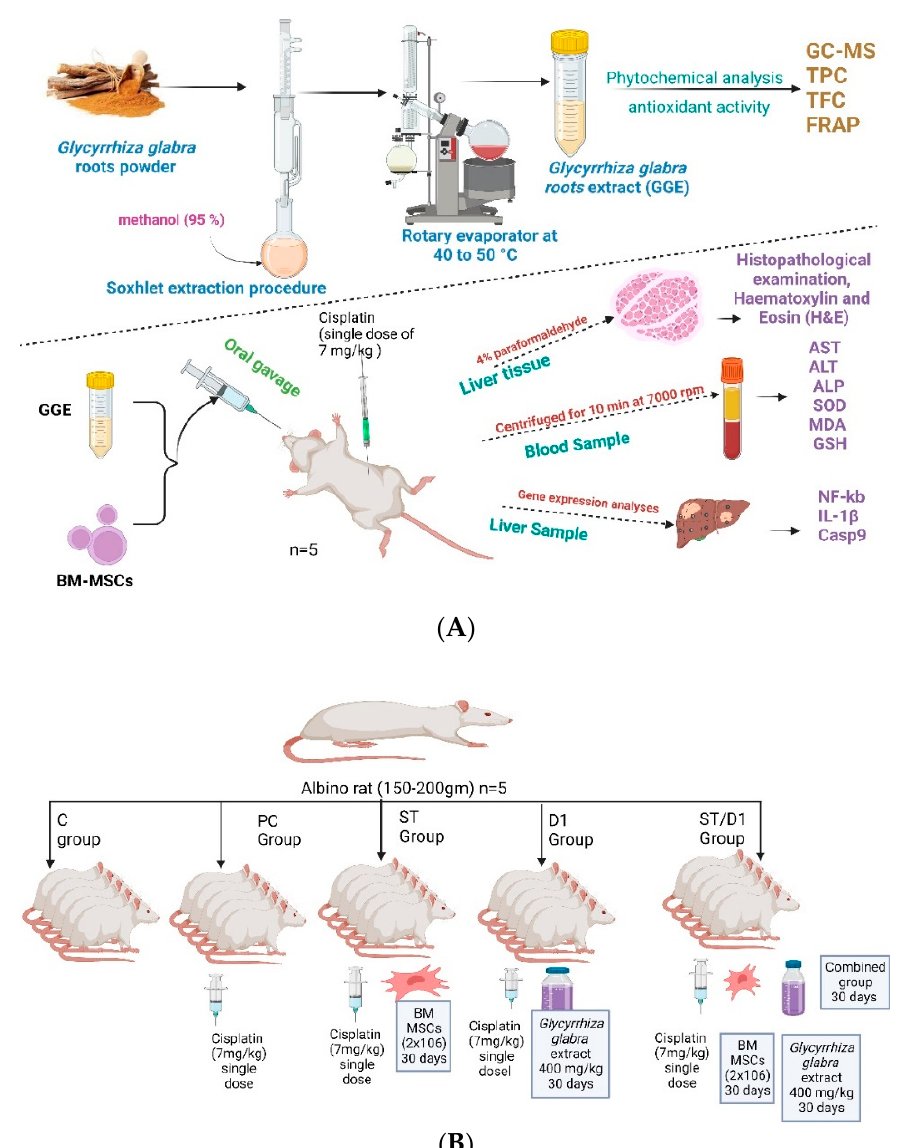
Figure 1. Experimental design and animal model.: ( A ) The experimental design. ( B ) The animal model with doses and duration .